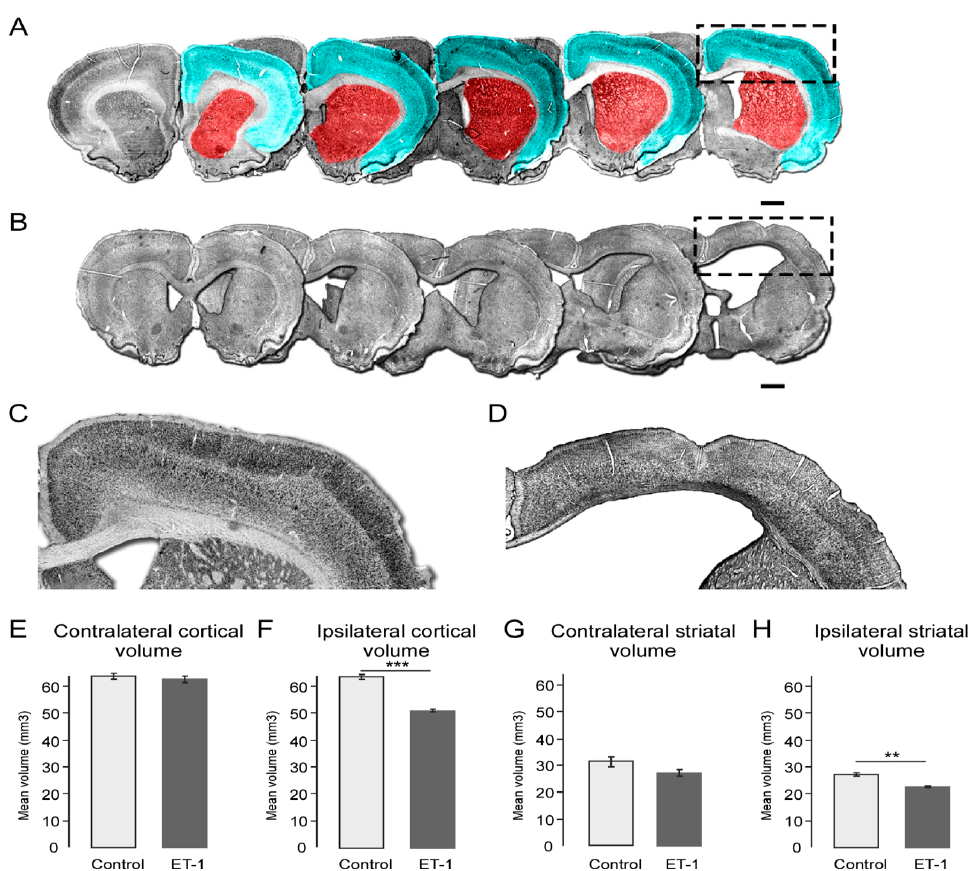
Figure 2. Quantification of cortical and striatal volumes 24 weeks after ischemic injury. ( A ) The cortical (cyan) and striatal (red) regions quantified are illustrated in coronal sections from a representative control animal immunohistochemically labelled for NeuN. ( B ) Immunohistochemistry for NeuN in representative coronal sections spanning the rostro-caudal axis 24 weeks after ET-1 induced cortical ischemia illustrates gross anatomical impact including ventricular enlargement (boxed area enlarged in ( D )). Representative images of control ( C ) and ET-1 ( D ) cortical areas illustrate the cortical thinning and hydrocephaly resulting from ischemic injury. Quantification of cortical volume showed no significant change between the control and ET-1 groups in the contralateral hemisphere ( E ) but a significantly reduced volume in the ipsilateral hemisphere in ET-1-treated animals ( F ). Similarly, striatal volume was not changed in the contralateral hemisphere ( G ) but was reduced in the ipsilateral hemisphere of animals with neonatal ischemic injury compared to the control group ( H ). Scale bars = 1 mm. Error bars = 1 SEM, ** p < 0.01, *** p < 0.001, independent t -test, (Group size: Control n = 7; ET-1 lesion n =